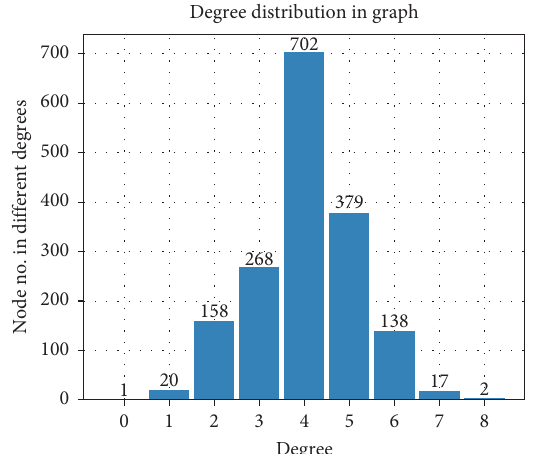
Figure 9: Distribution of node degree of road network graph in